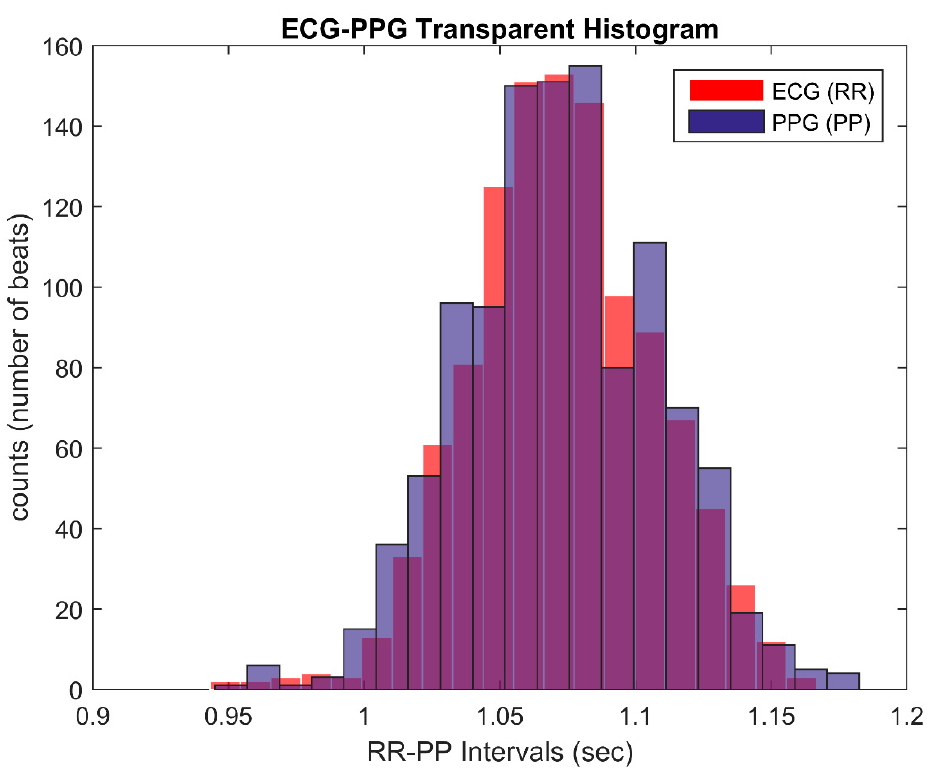
Figure 8. RR and PP intervals for a randomly chosen healthy subject.